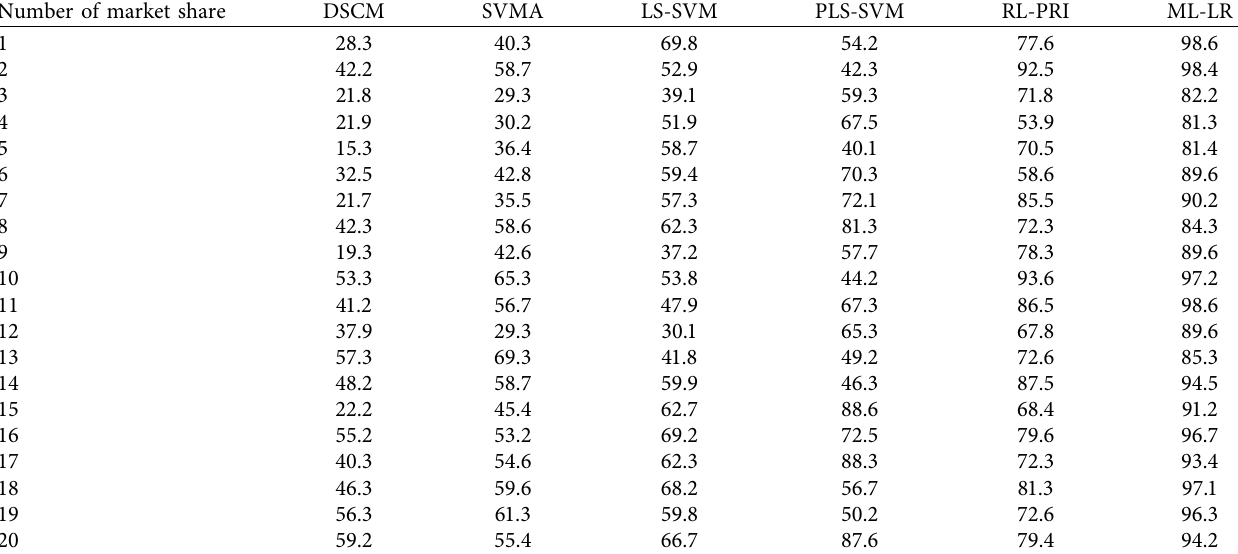
Table 3: Statistical data on the financial credit risk in supply chain finance companies. Number of market